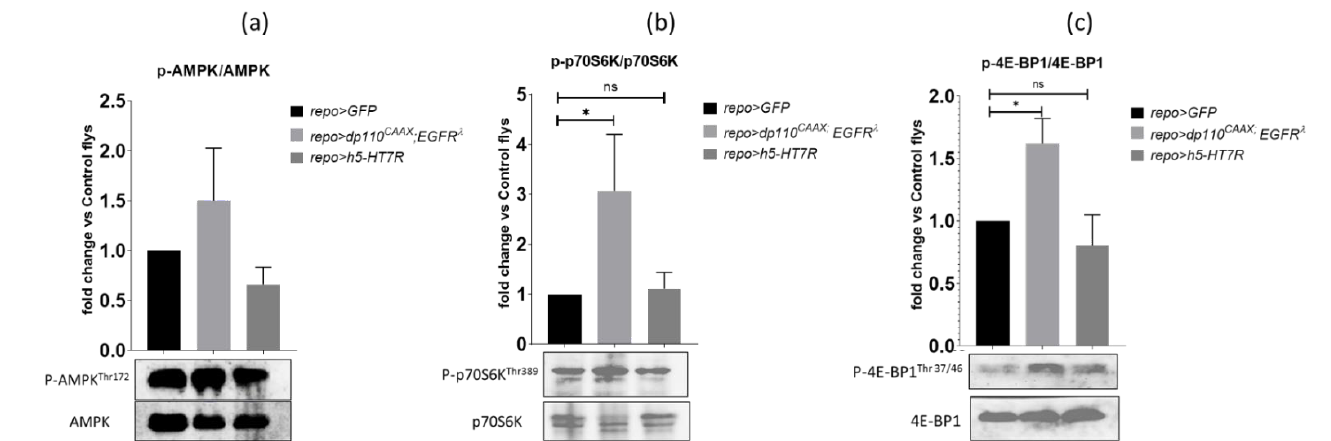
Figure 10. Evaluation of phosphorylation of AMPK, p70S6K and 4E-BP1 in glioma and in brains expressing h5-HT7R alone. Western blots of larval brains of controls (repo>GFP), glioma (repo>dp110 CAAX ; dEGFR λ ) and expressing h5-HT7R alone (repo>h5-HT7R) probed with ( a ) p- AMPK Thr172 and AMPK antibodies, ( b ) p-p70S6K Thr389 and p70S6K antibodies and ( c ) p-4E-BP1 Thr37/46 and 4E-BP1 antibodies. Quantification of mean fold change in phosphorylation was analyzed